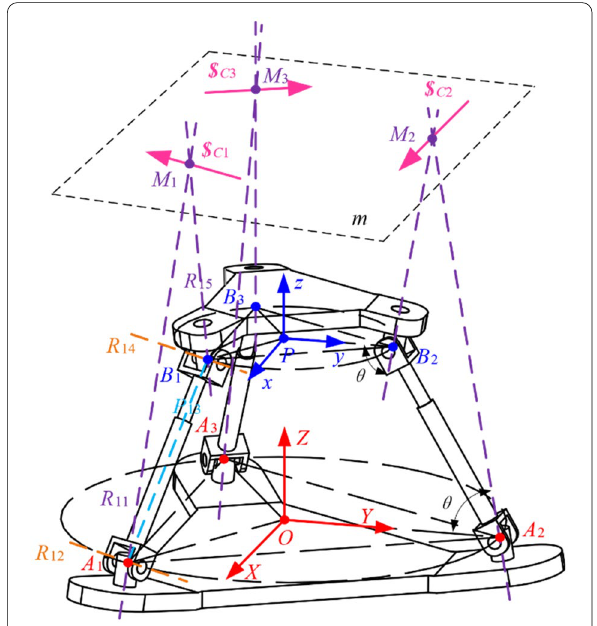
Figure 1 Structure diagram of M-RCM 3-UPU